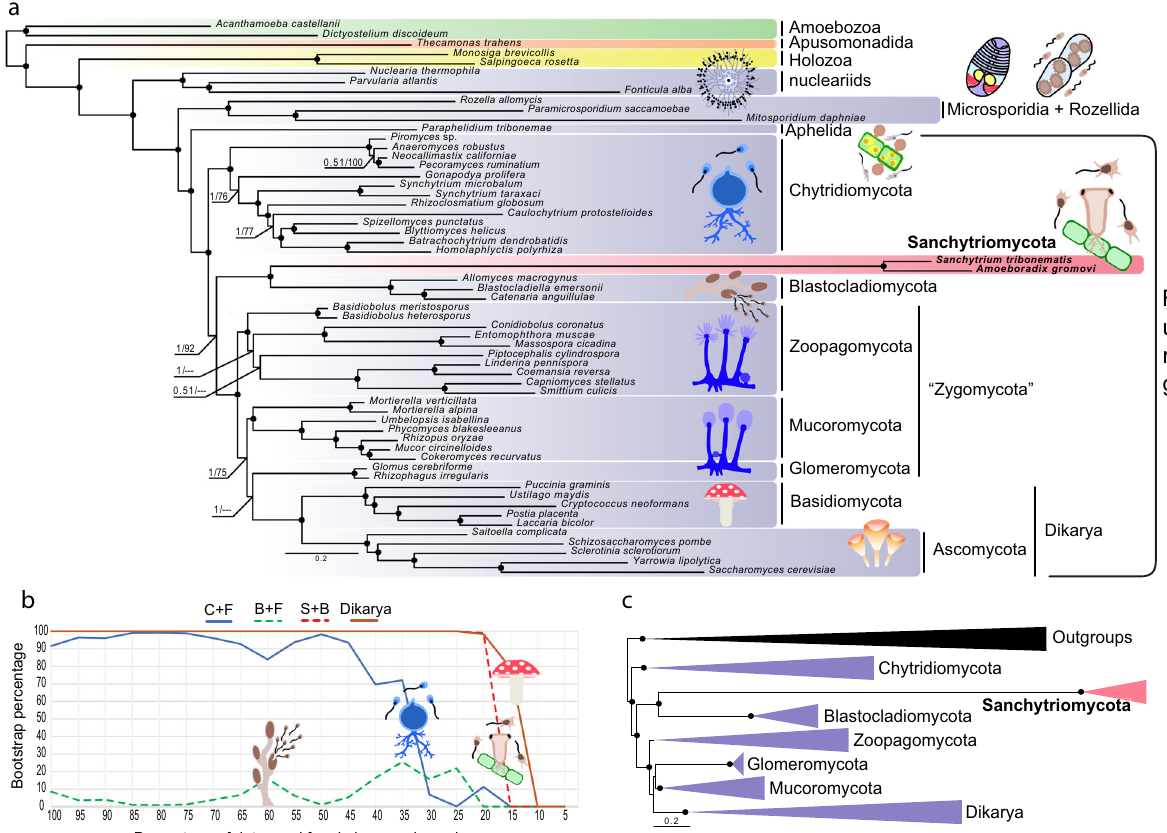
Fig. 2 Phylogenomic analysis of Holomycota. a Bayesian inference (BI) phylogenomic tree based on the GBE dataset of 264 conserved proteins (93,743 amino acid positions). The tree was reconstructed using 59 species and the CAT-Poisson model and the PMSF approximation of the LG + R8 + C20 model for maximum likelihood (ML). b Evolution of IQ-TREE ML bootstrap support for Chytridiomycota sister to all other fungi (C + F), Blastocladiomycota + Sanchytriomycota sister to all other fungi (B + F), Sanchytriomycota within Blastocladiomycota (S + B), and the monophyly of Dikarya (Dikarya) as a function of the proportion of fast-evolving sites removed from the GBE59 dataset. Holomycota are highlighted in violet, sanchytrids in pink and outgroup taxa in other colours (green, orange and yellow). All phylogenomic trees can be seen in Supplementary Fig. 2a – e. c Schematic BI phylogeny showing the results obtained with the BMC dataset of 53 conserved proteins (14,965 amino acid positions) using 59 species (Fungi: violet; Sanchytriomycota: red; outgroup taxa: black) and the CAT-GTR model (BI) and the PMSF approximation of the LG + R7 + C60 model for maximum likelihood (ML). In both trees, branches with support values ≥ 0.99 BI posterior probability and 99% ML bootstrap are indicated by black fungi and their closest aphelid relatives (i.e. Paraphelidium ), but